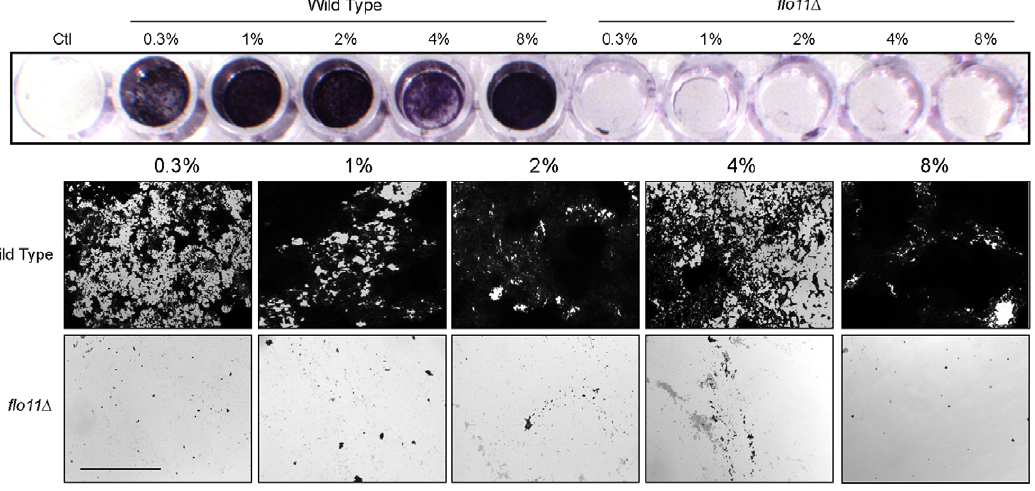
Figure 5. Yeast mats grown on a variety of surface rigidities exhibit Flo11-dependent adherence. Mats of wild type (PC 538) and flo11 D (PC 1029) mutant were grown for 11 days on YEPD medium containing % agar concentrations as indicated. Adherence of cells in different mats was estimated by adherence to plastic using crystal violet dye. The control well (Ctl) contained water only. Below, photomicrographs of the wells are shown. Top panels, wild type; bottom panels, flo11 D . Agar concentrations are as indicated. Bar=10 m m.